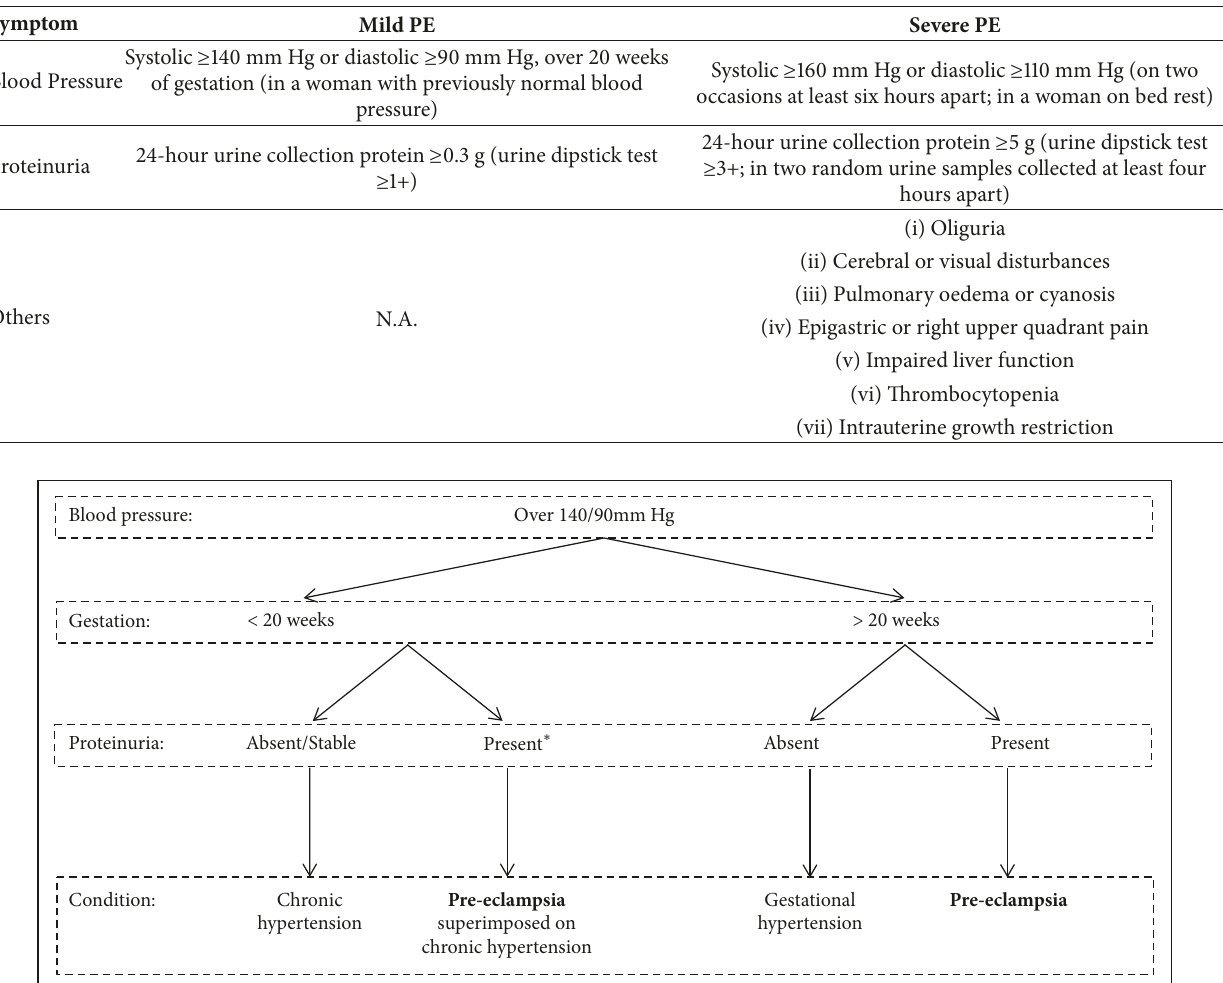
Table 1: Symptoms presented by patients with mild and severe PE. The diagnosis of any form of PE requires the presentation of both hypertension and proteinuria. This may be accompanied by a multitude of other symptoms if the PE is severe [8, 9].